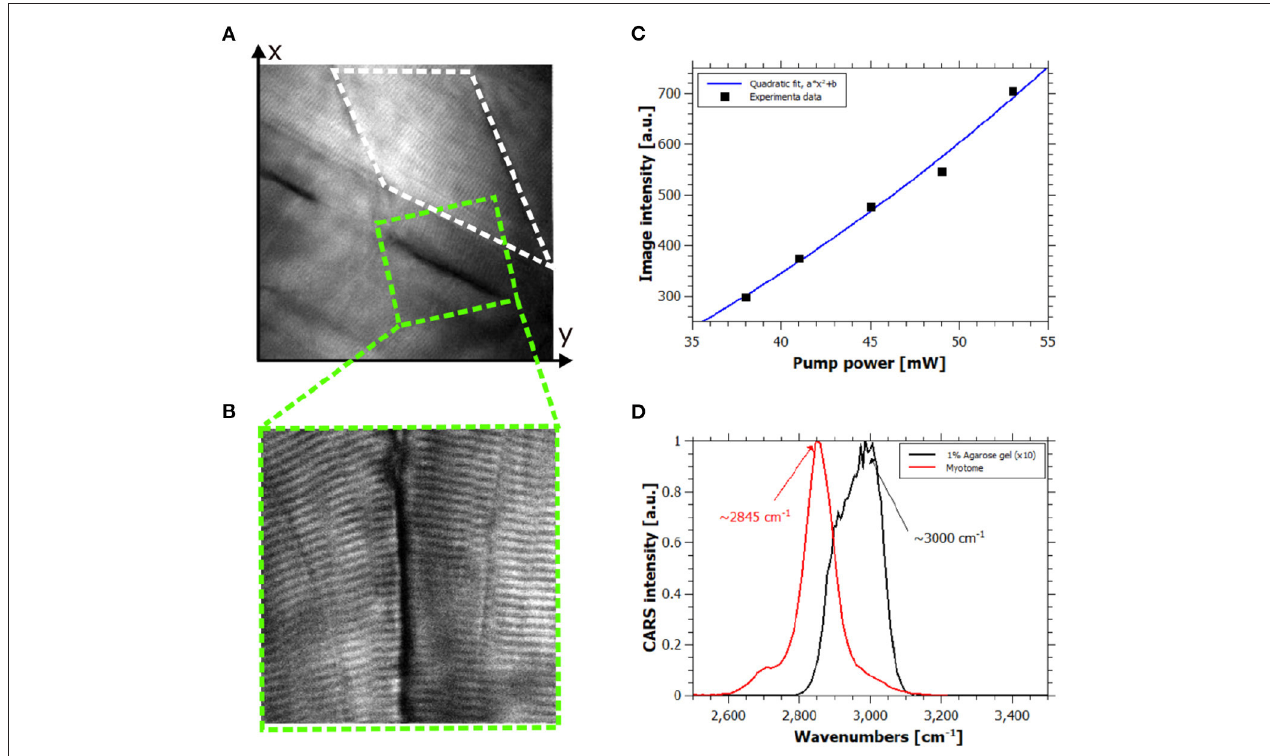
FIGURE 2 | In vivo hyperspectral coherent anti-Stokes Raman scattering (CARS) images. (A) CARS image of healthy zebrafish larva at 120 hpf at 2,845 cm − 1 , field of view (FOV) is 80 × 80 µ m 2 . (B) High-resolution CARS image of the green dashed square in (A) showing contrast coming from the lipid content of the muscle cells, FOV is 30 × 30 µ m 2 . (C) Quadratic power dependency of the CARS signal of the white dashed rectangle area in (A) respect to the pump power intensity. R-squared of the quadratic fit is 0.9889. (D) Spectral information provided by hyperspectral CARS allowing discrimination between the resonant signal of lipids and 1% agarose gel.